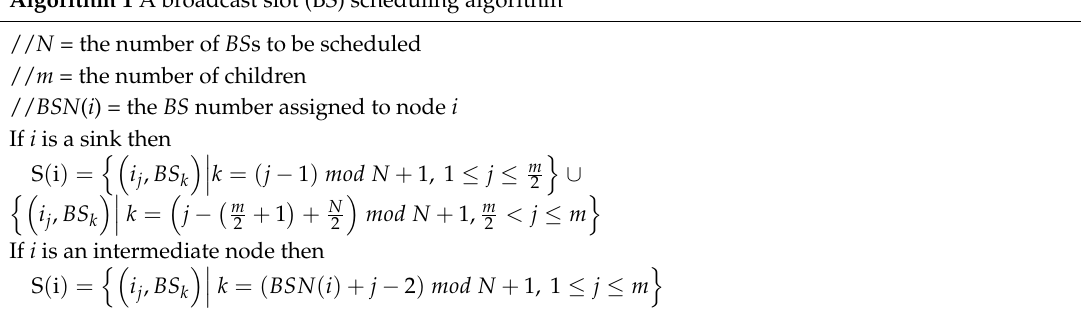
Algorithm 1 A broadcast slot (BS) scheduling